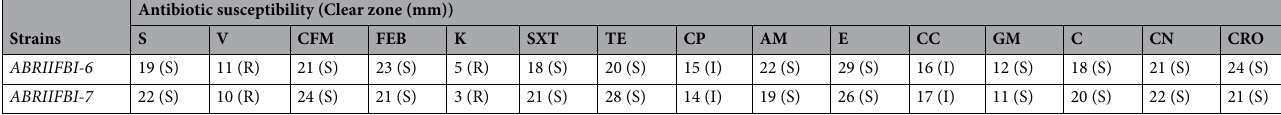
Table 1. Antibiotic susceptibility of selected strains against the high consumption antibiotics performed by disk diffusion assay. S streptomycin, V vancomycin, CFM cefixime, FEB cefepime, K kanamycin, SXT sulfamethoxazole, TE tetracycline, CP ciprofloxacin, AM ampicillin, E erythromycin, CC clindamycin, GM gentamycin, C chloramphenicol, CN cephalexin, CRO ceftriaxon. Erythromycin results based on R ≤ 13 mm; I: 13–23 mm; S ≥ 23 mm. Gentamycin results based on R ≤ 6 mm; I: 7–9 mm; S ≥ 10 mm. Vancomycin results based on R ≤ 12 mm; I: 12–13 mm; S ≥ 13 mm. I: intermediate (zone diameter, 12.5–17.4 mm); R: